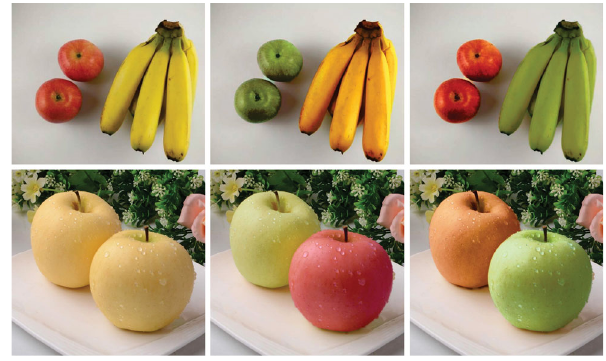
Fig. 5 Transfer results for images with multiple objects.